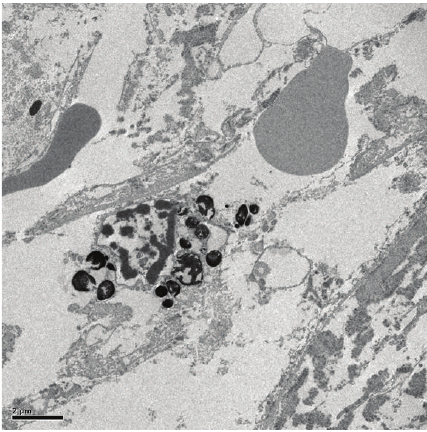
Figure 5: TEM of SLT-treated tissue (0.7mJ). Extracellular, cracked pigment granules are noted.